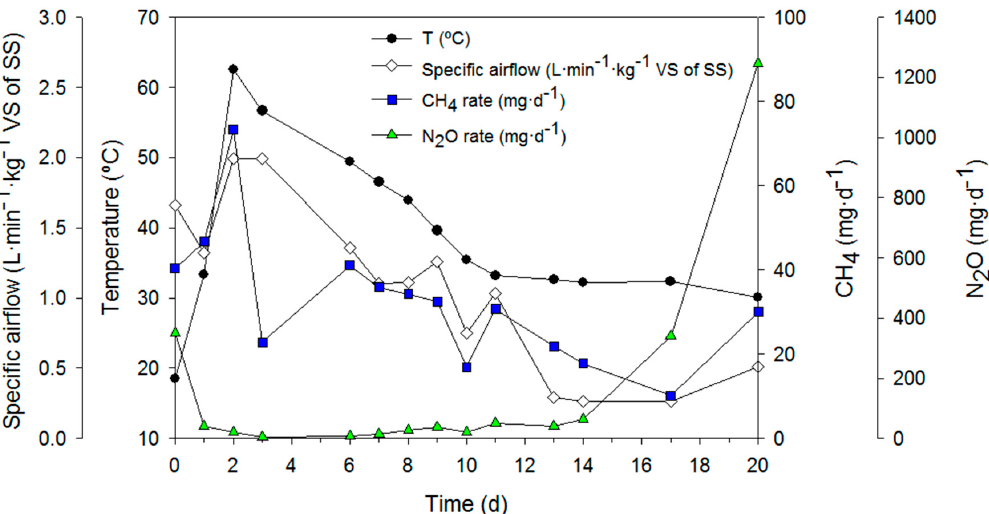
Figure 3. CH 4 and N 2 O emission rate profiles during the composting process. Black dots represent the average temperature of the reactor ( ◦ C); white diamonds represent the specific airflow passed through the reactor (L · min − 1 · kg − 1 VS of SS); blue squares represent the emission rate of CH 4 (mg CH 4 · d − 1 ); green triangles represents the emission rates of N 2 O (mg N 2 O · d − 1